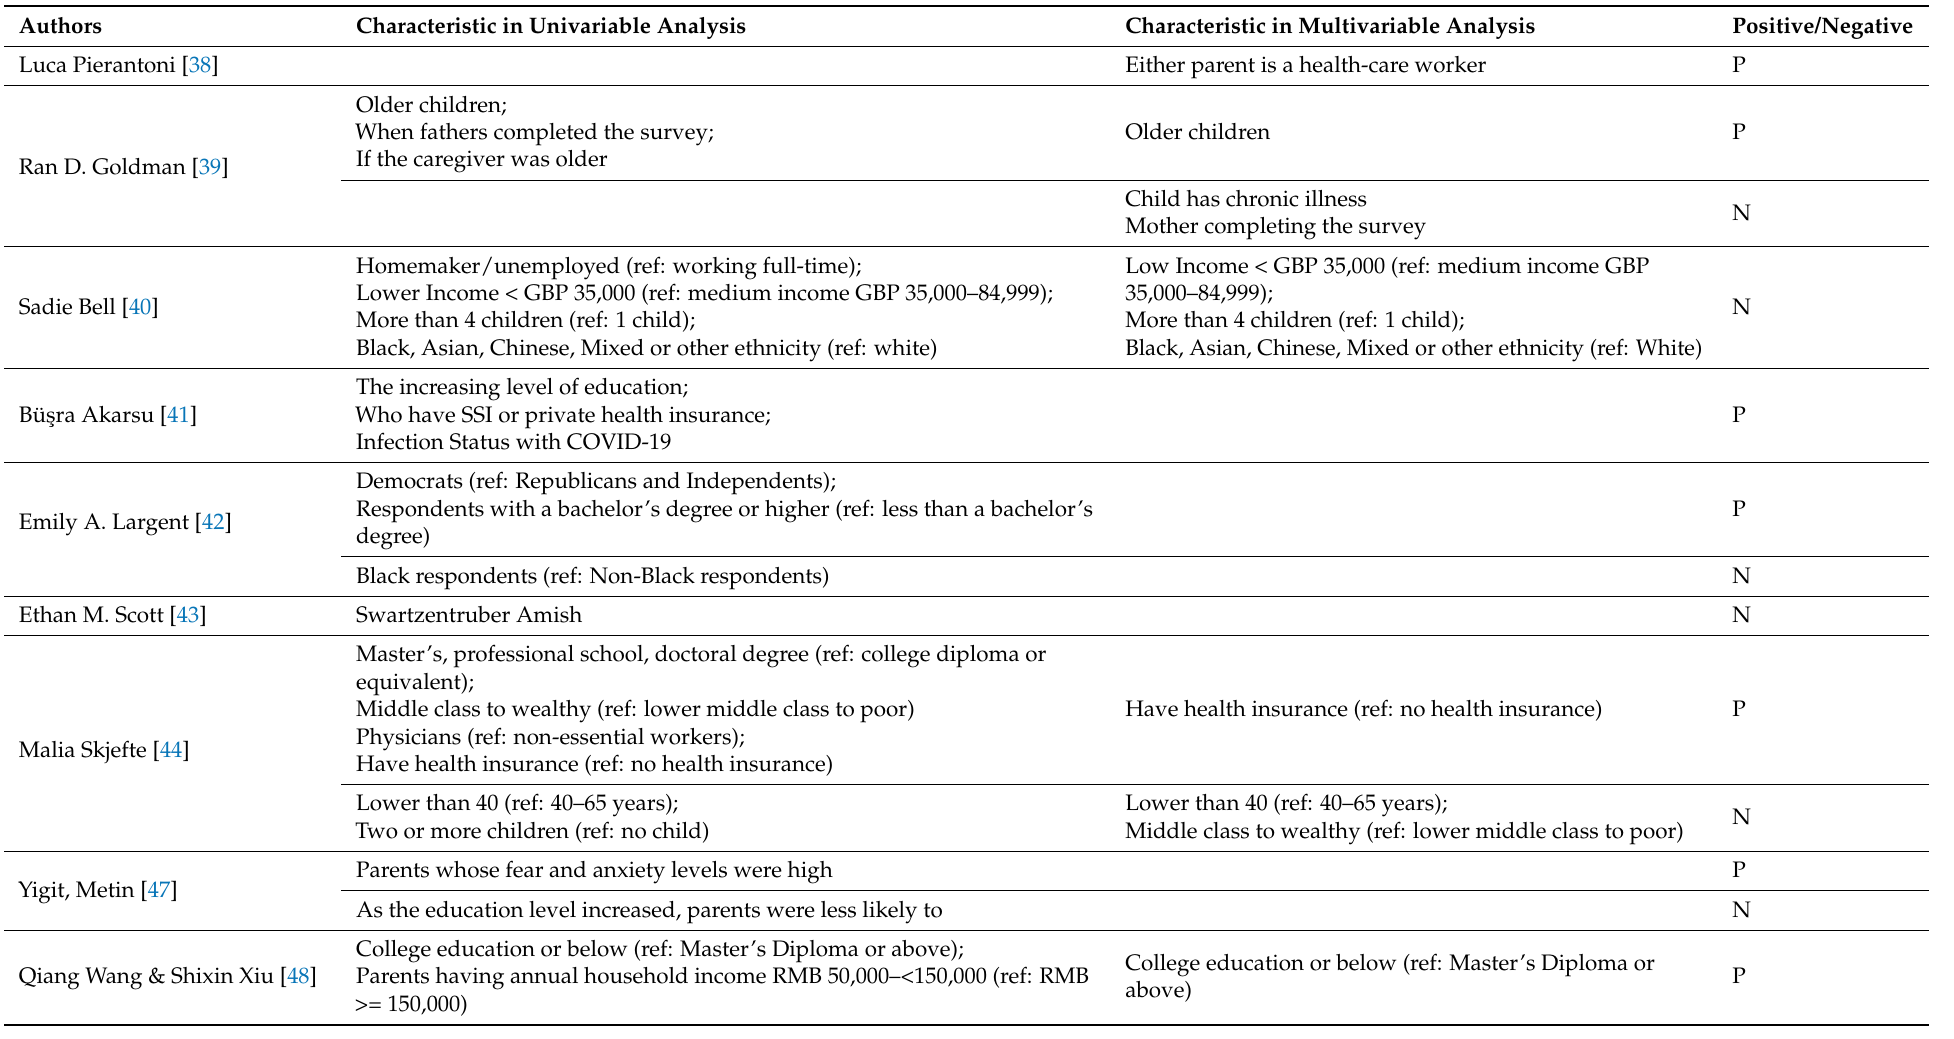
Table 3. Objective factors influencing parents’ decision to vaccinate children against